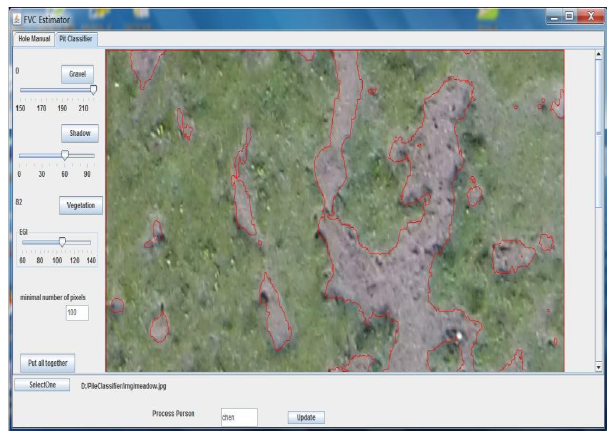
Figure 1. Vegetation patch extraction software